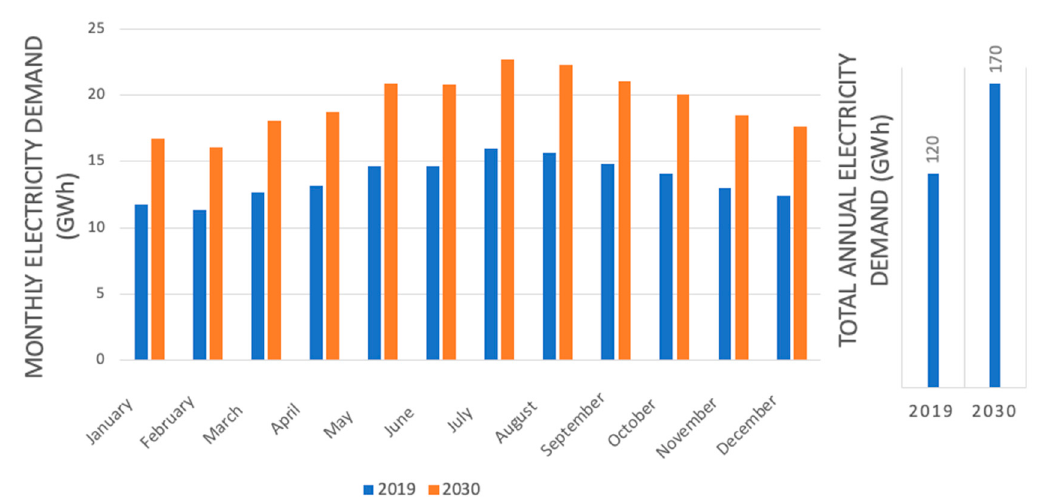
Figure 7. Total monthly and annual electricity demand in Isla de la Juventud in 2019 and 2030. Source: ONEI [42] and author defined.